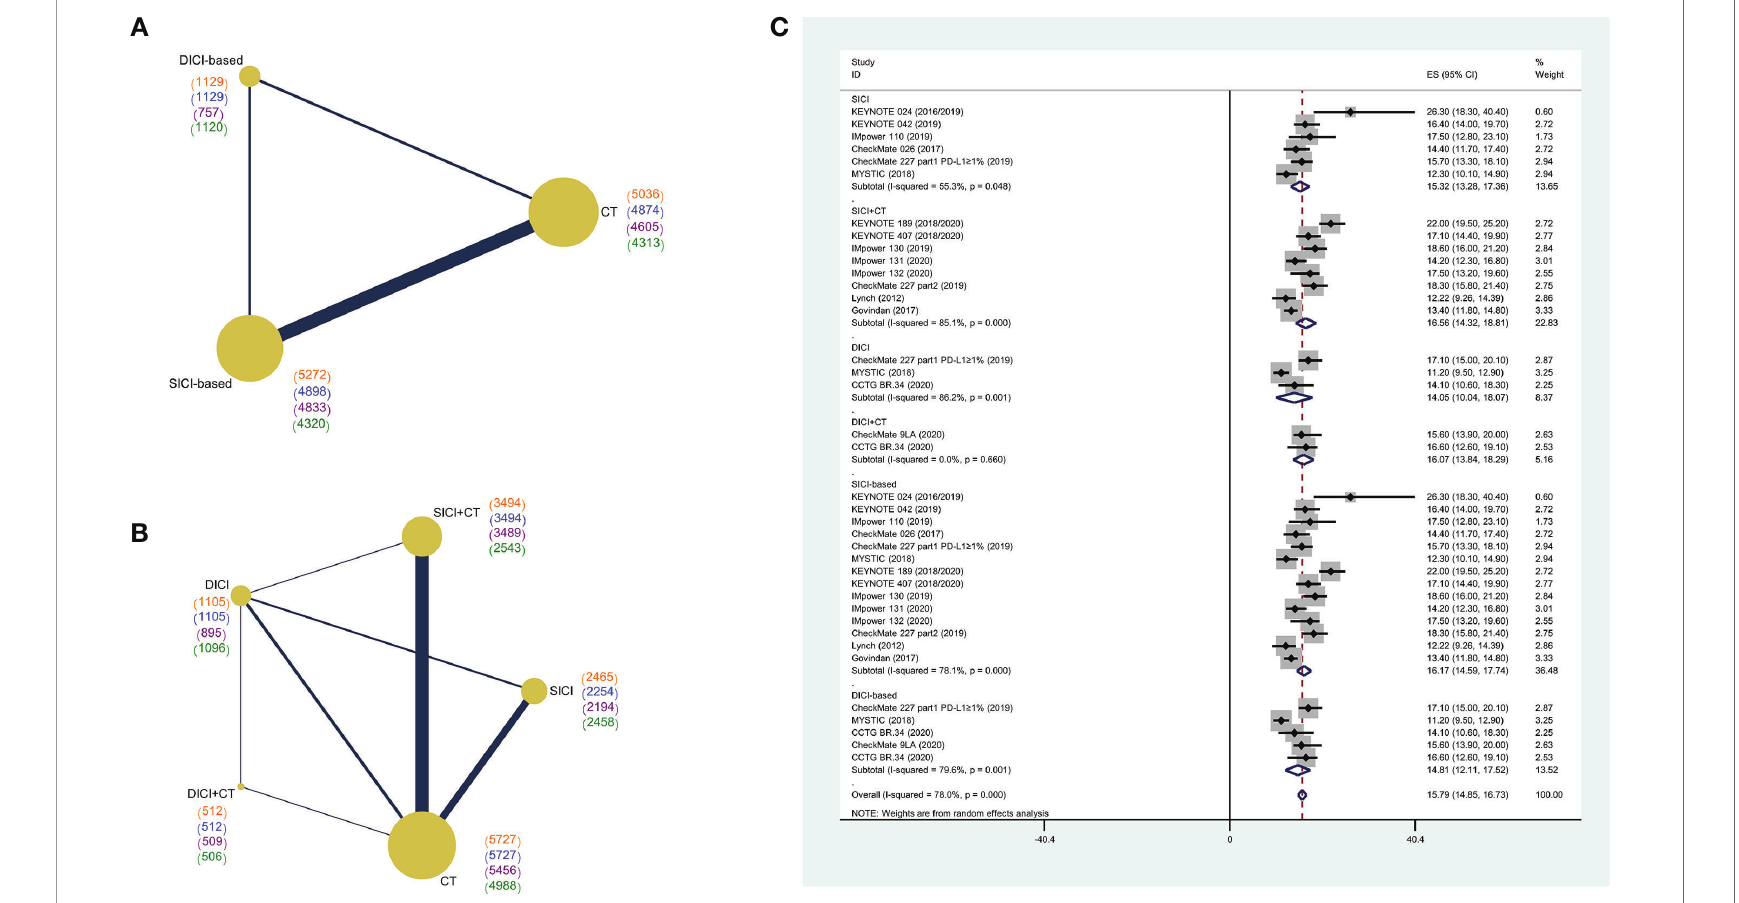
FIGURE 2 | Network diagram of comparisons on different outcomes of treatments and pooled estimates of median overall survival. (A) Network diagram of SICI or DICI-based treatments and CT. (B) Network diagram of SICI, DICI, SICI+CT, DICI+CT, and CT. Each circular node represents a type of treatment. The size of the nodes and the thickness of the lines are weighted according to the number of studies evaluating each treatment and direct comparison, respectively. The total number of patients receiving treatments was shown in brackets. Color “ orange ” for overall survival (OS), “ blue ” for progression-free survival (PFS), “ purple ” for objective response rate (ORR), “ green ” for adverse events of grade 3 or higher ( ≥ 3AEs). (C) Pooled median overall survival (POS) of treatments in the overall population. SICI-based, treatments including single immune checkpoint inhibitor; DICI-based, treatments including double immune checkpoint inhibitors; SICI, single immune checkpoint inhibitor; DICI, double immune checkpoint inhibitors; SICI+CT, single immune checkpoint inhibitor combined with chemotherapy; DICI+CT, double immune checkpoint inhibitors combined with chemotherapy; CT,